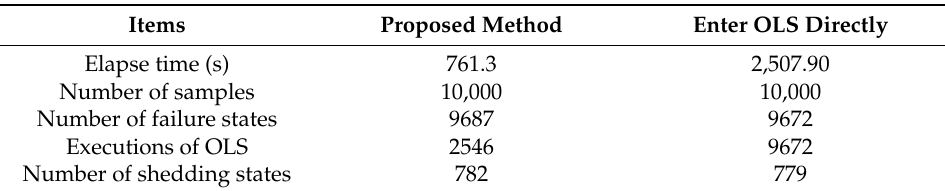
Table 5. The efficiency of the preliminary analysis.